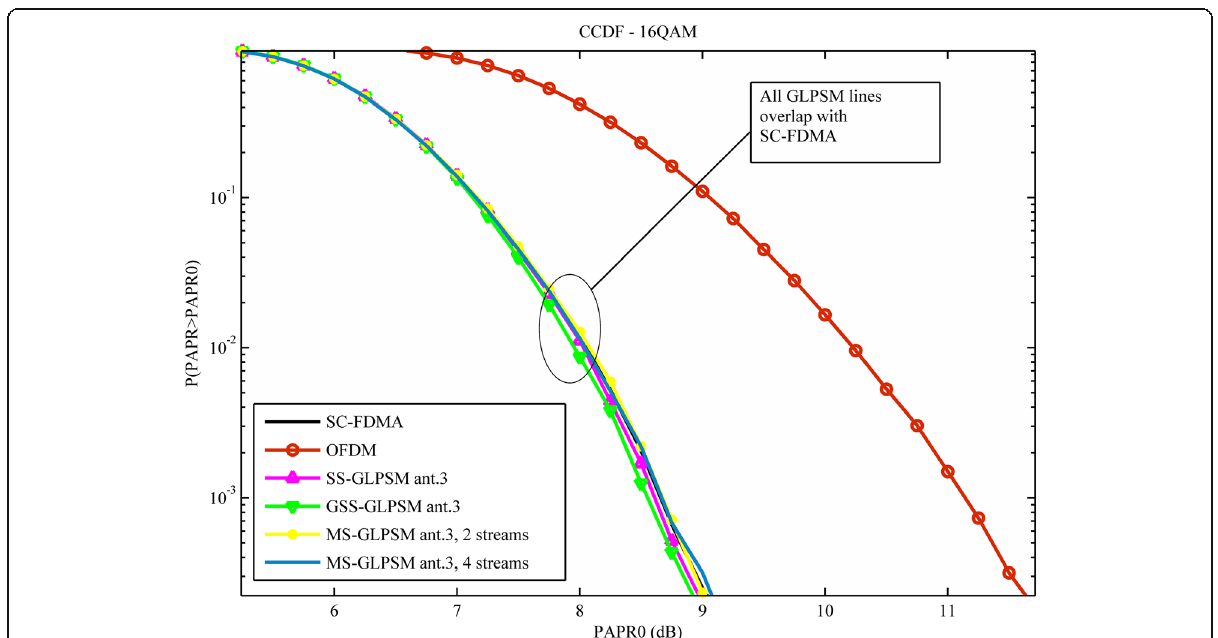
Fig. 3 PAPR comparison for SC-FDMA GLPSM in the case of eight transmit antennas. The figure presents the PAPR comparison for all three proposed GLPSM techniques (SS-GSLPM, GSS-GLPSM, and MS-GLPSM) and the conventional SC-FDMA and OFDM, given as the references. All transmit antennas have similar PAPR curves, hence, for the sake of clarity, only curves for antenna 3 are presented. In all observed techniques, the underlying modulation is 16-QAM. It can be concluded that all three proposed techniques maintain the same PAPR level as the conventional SC- FDMA and that their PAPR levels are determined by the underlying modulation. Furthermore, MS-GLPSM maintains the same PAPR level regardless of the number of streams